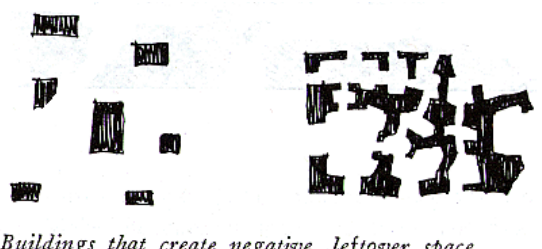
Figure. 5. Building integration in creation of negative space and positive outdoor space. (Alexander et all 1980